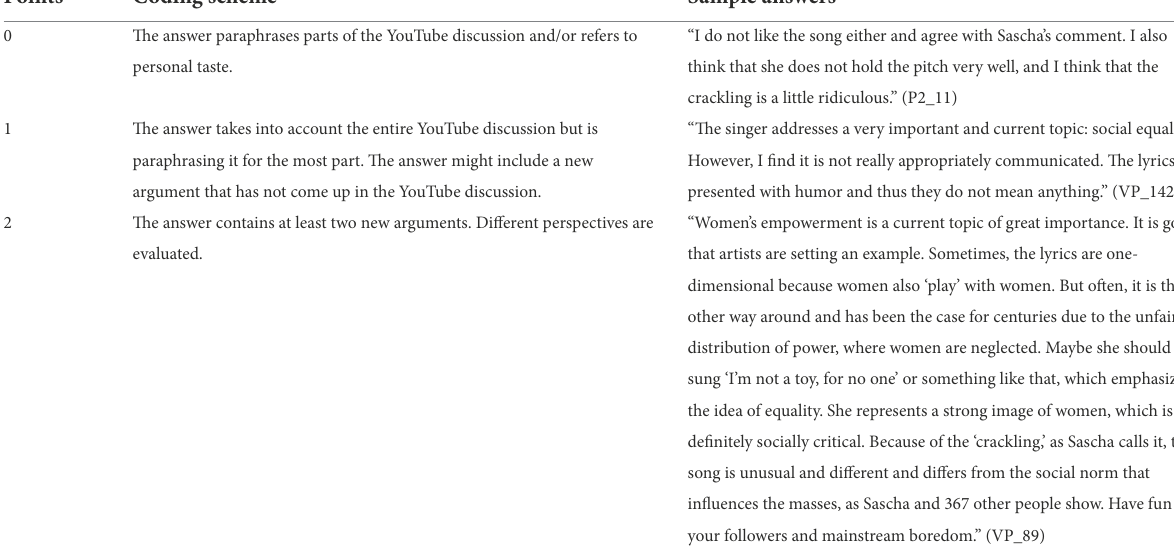
TABLE 2 Coding scheme for the item “Eurovision song contest” (English translation). Points Coding